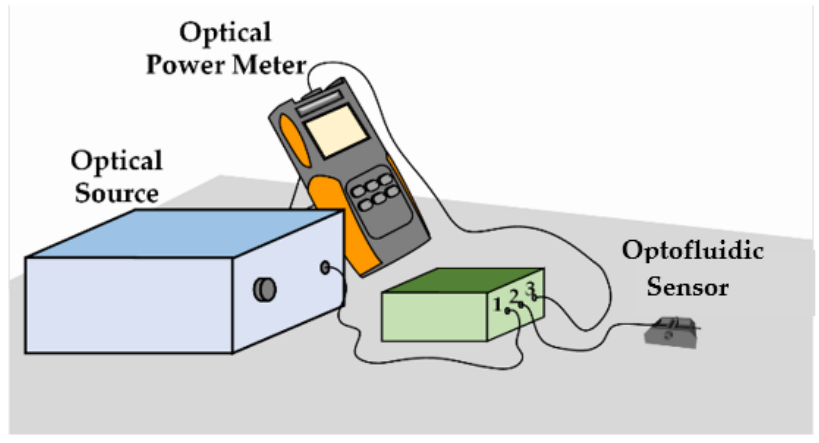
Figure 3. Schematic diagram of experimental setup.